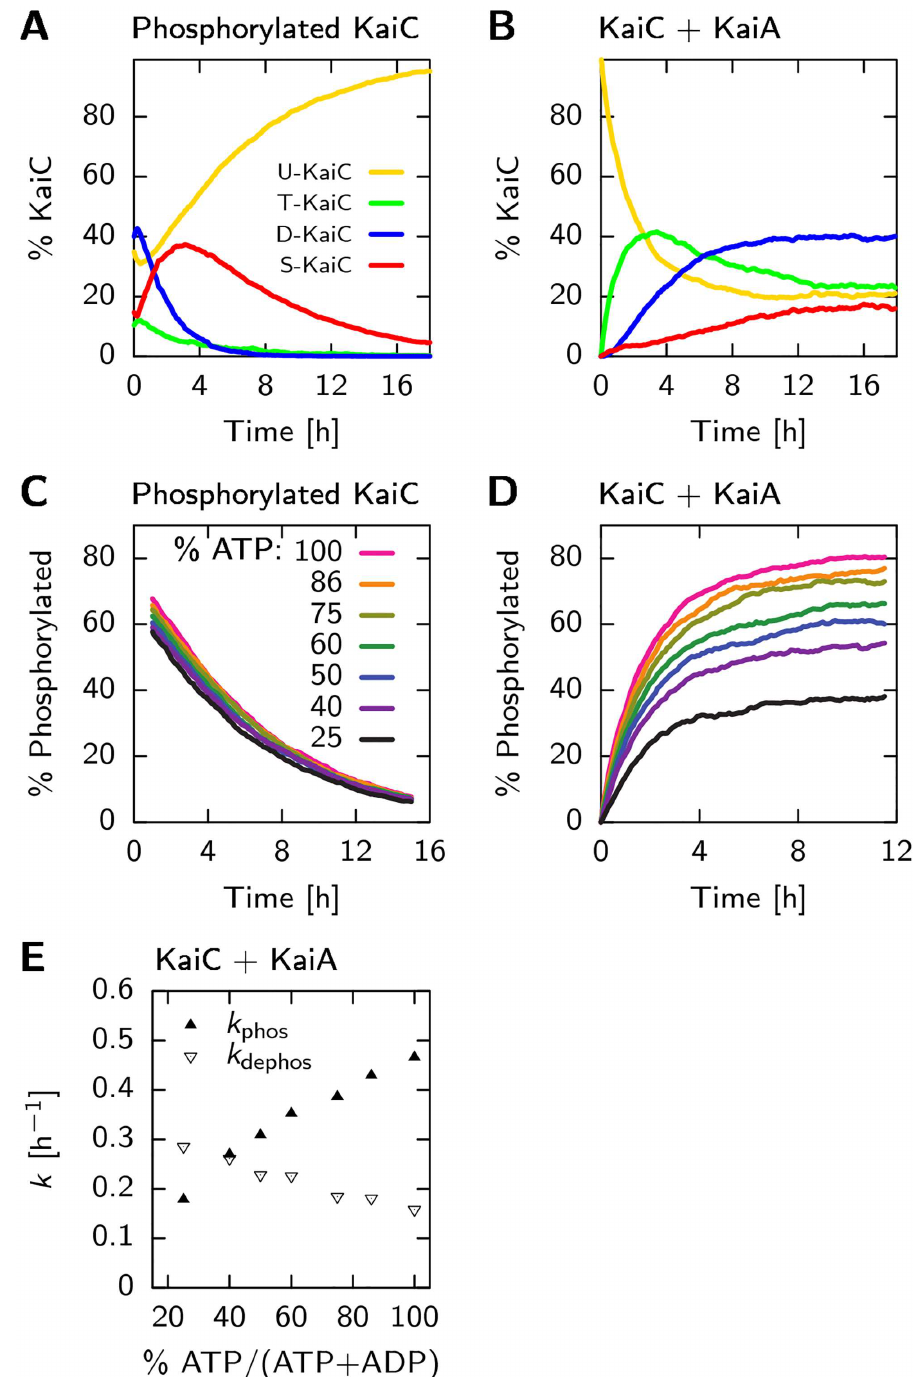
Fig 6. The free-energy landscape in Fig 3, accurately describesthe phosphorylation and dephosphorylation dynamics in the CII domain, both with and without KaiA and for a wide range of different ATP to ADP fractions in the solution, α ATP . (A) Dephosphorylationdynamics, starting with phosphorylated KaiC and (B) phosphorylation dynamics, startingwith unphosphorylatedKaiC and KaiA. (C) Dephosphorylationand (D) phosphorylationof KaiC under similarconditionsas in panelsA and B, respectively, but now for different bulk fractions of ATP, α ATP . Consistent with experiments, the rate of dephosphorylationis independent of α ATP , but the phosphorylation-ratedoes dependstronglyon this fraction. (E) Rates of (de) phosphorylation in panelD, foundby fitting Eq 16 to the first four hoursof phosphorylation data.